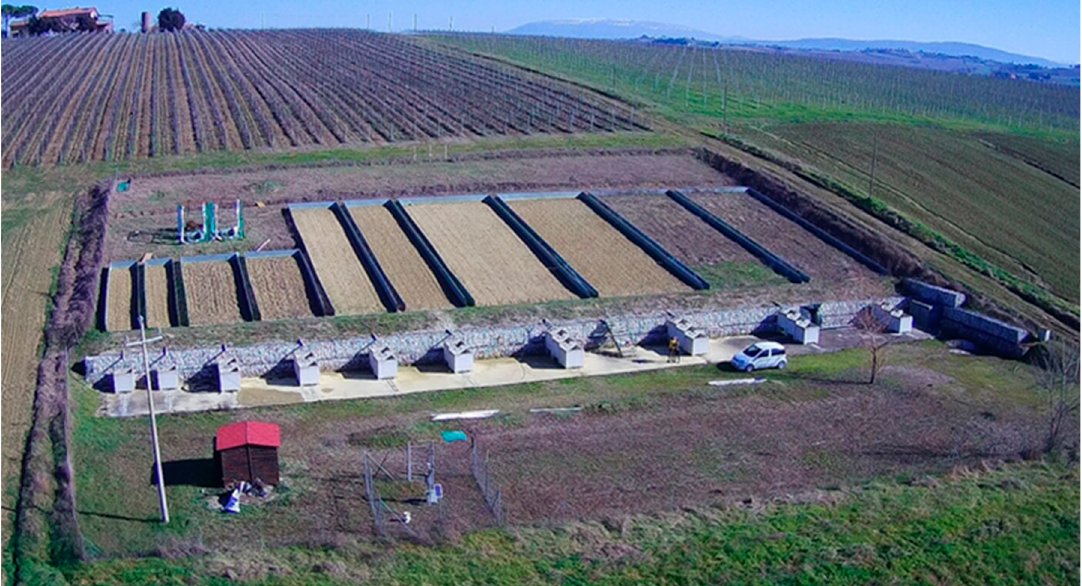
Figure 1. View of the Masse experimental station, SERLAB (Central Italy). (42°59 ′ 34 ″ N 12°17 ′ 27 ″ E). All plots are oriented parallel to a 16% slope. The area has a characteristic Mediterranean climate with an average annual rainfall of about 900 mm. The soil texture is silty-clay-loam (clay = 34%, silt = 59%, and sand = 7%) and the gravel content is negligible. The soil structure, massive when the soil is wet, becomes weak, fine, subangular, and blocky upon drying.